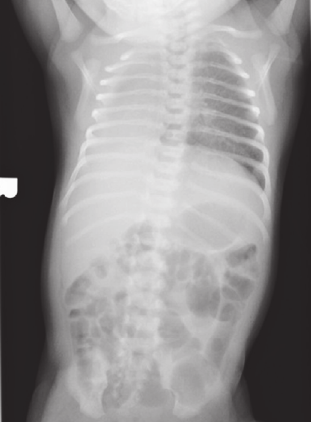
Figure 3: X-ray neck revealing Klippel-Feil